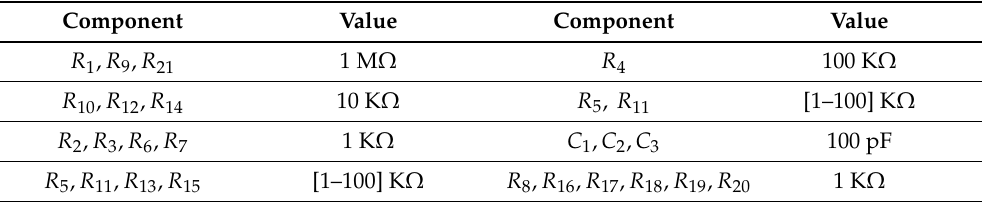
Figure 1. ( a ) Circuit diagram of the generator for Brownian-like motion described by Equation (3). ( b ) Experimental setup for data acquisition from electronic implementation. Table 1. Values used in the electronic implementation of the deterministic Brownian-like motion